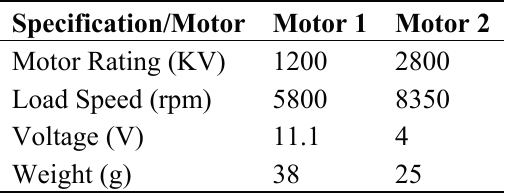
Table 4. Motor specification